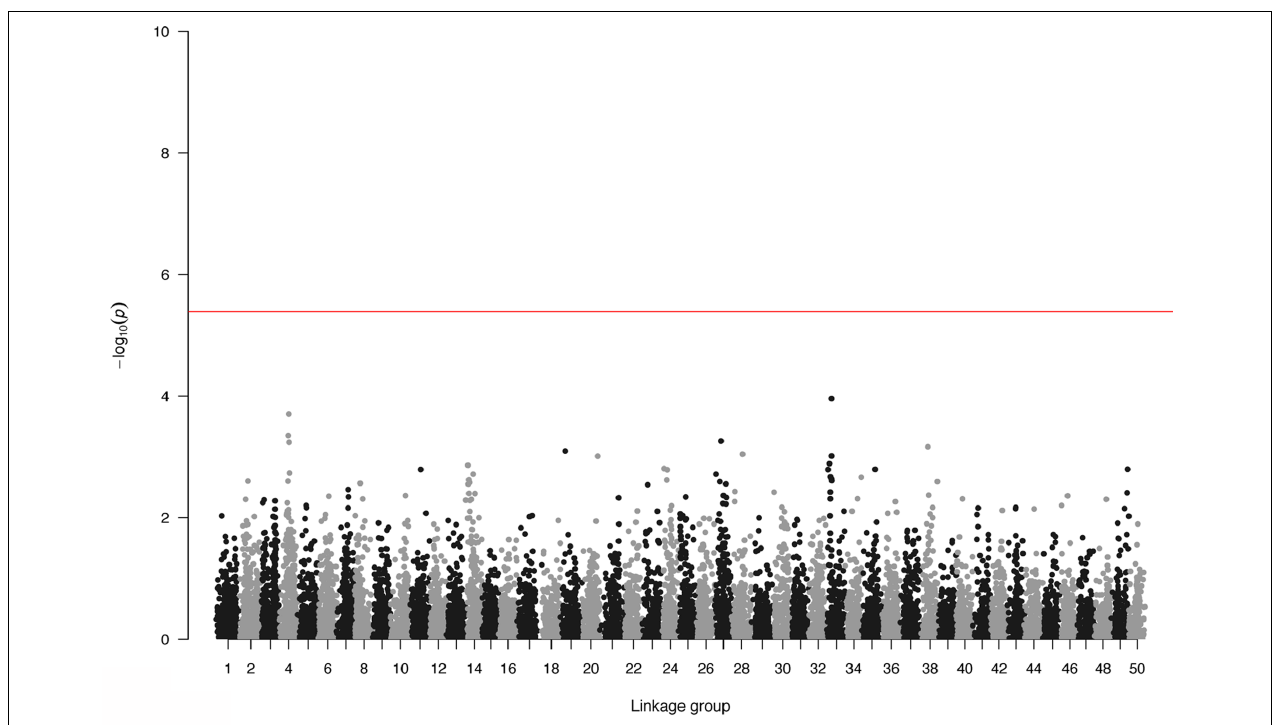
FIGURE 2 | Genome-wide association plot for body